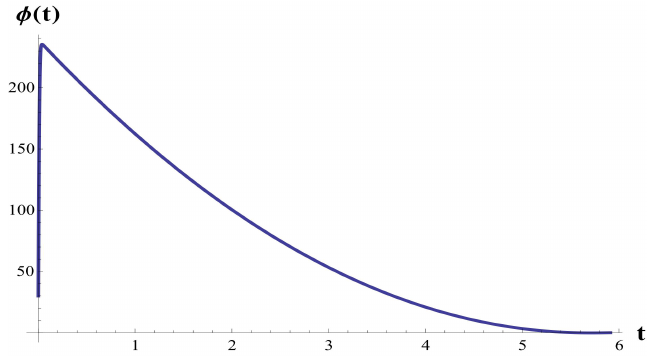
Figure 2. Numerical profile of φ ( t ) corresponding to a ( t ) given in 1.